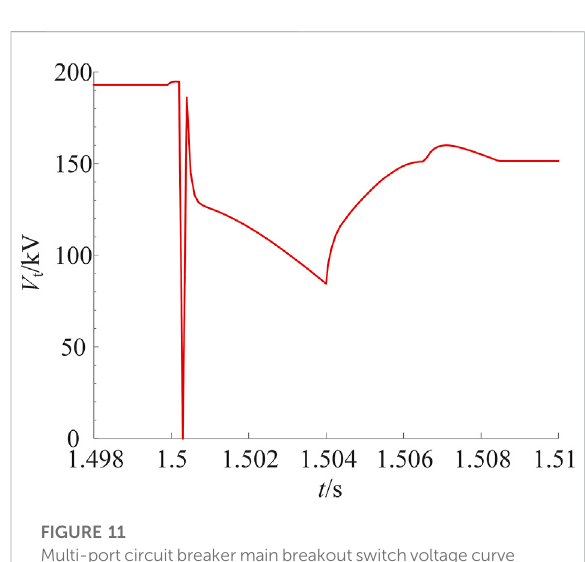
FIGURE 11 Multi-portcircuitbreakermainbreakoutswitchvoltagecurve at both